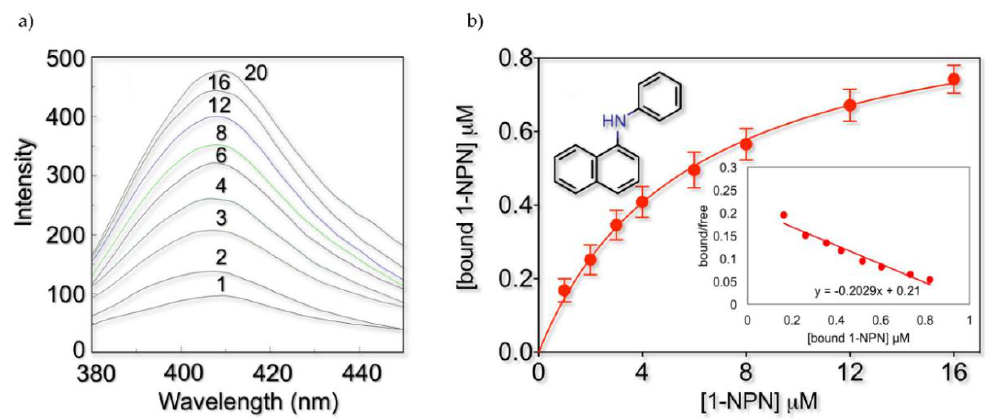
Figure 1. 1-NPN binding to rFel d 1. To a 1- µ M solution of the protein in 50 mM Tris-HCl, pH 7.4, aliquots of 1 mM solution of 1-NPN in methanol were added to final concentrations of 1–20 µ M. ( a )